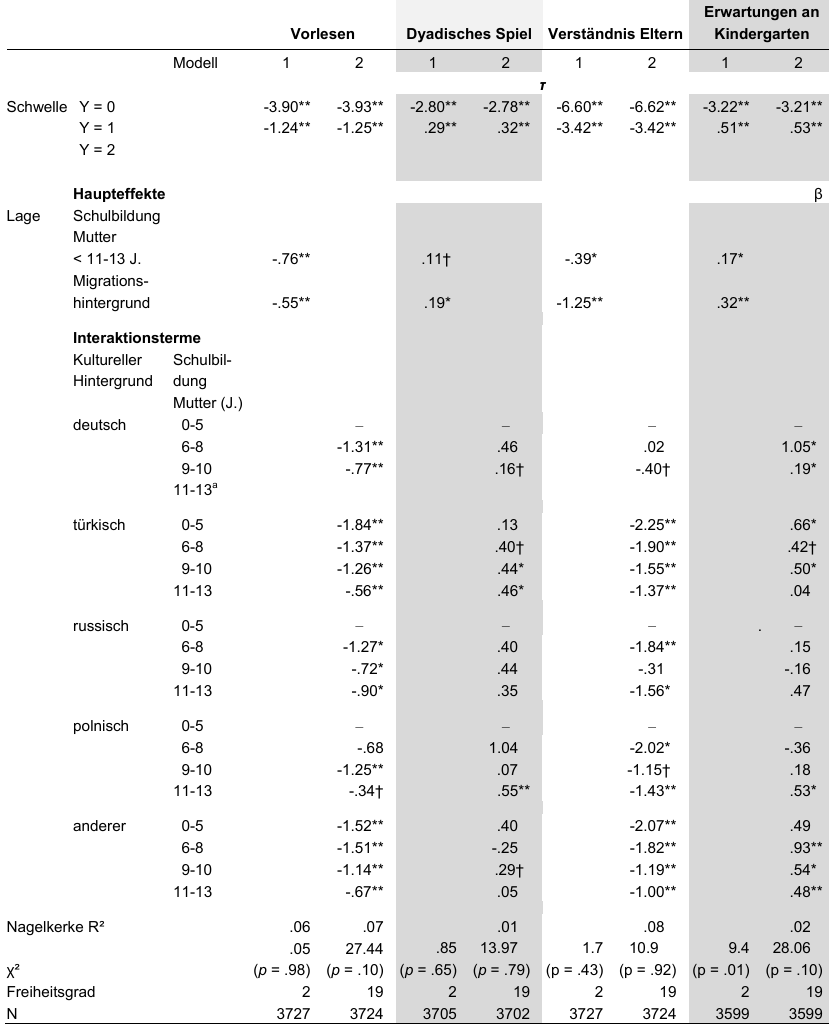
Tabelle 2: Erklärung elterlicher Einstellungen mit kumulativen